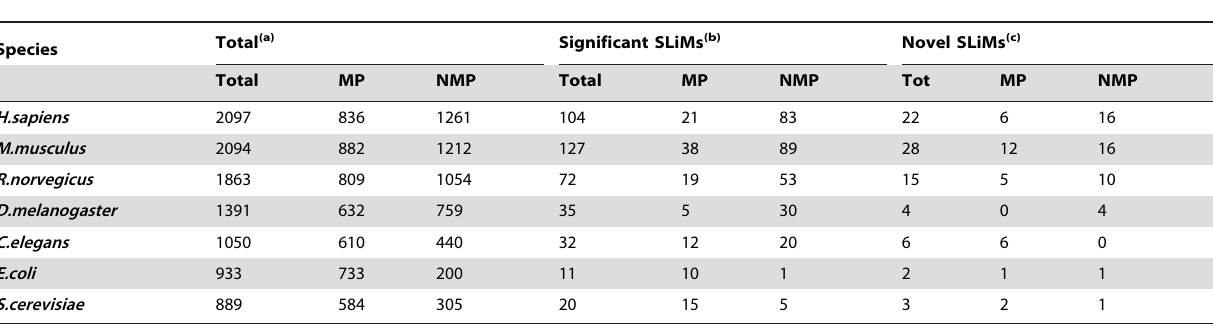
Table 1. Number of motifs predicted in KEGG